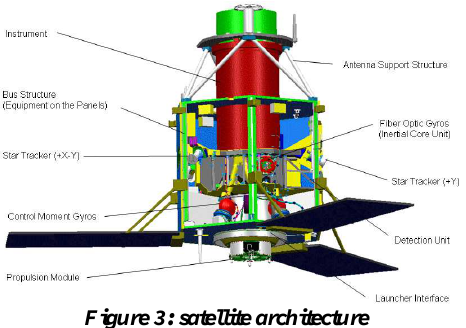
Figure 3: satellite